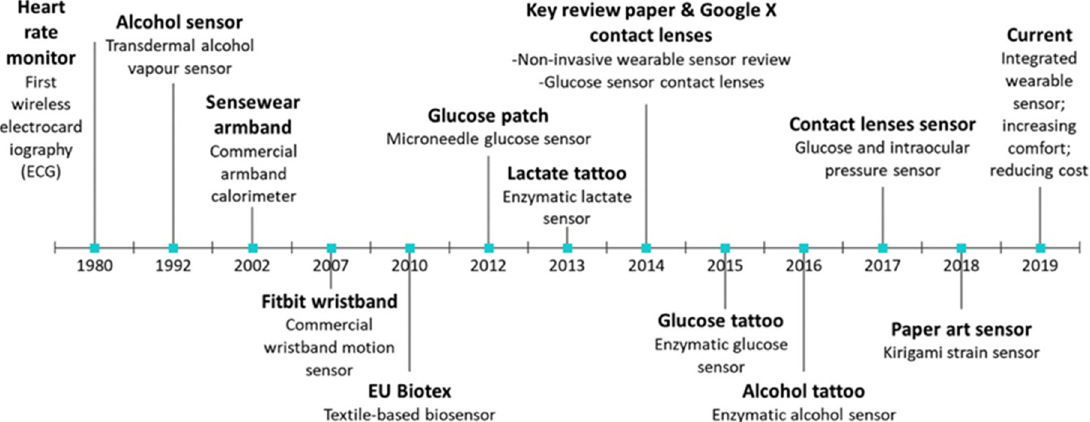
Figure 1. Key milestones of wearable sensors over the years. Reproduced with the permission of Reference [11]. Copyright 2021 Elsevier.